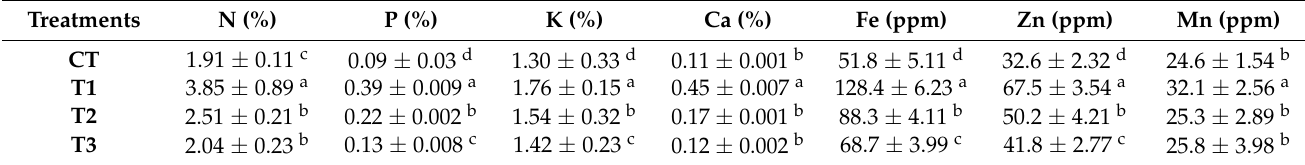
Table 3. Impacts of different iron sources (nano, chelated, and sulfate), as foliar spray on seed’s nutrients content of Vicia faba plants.